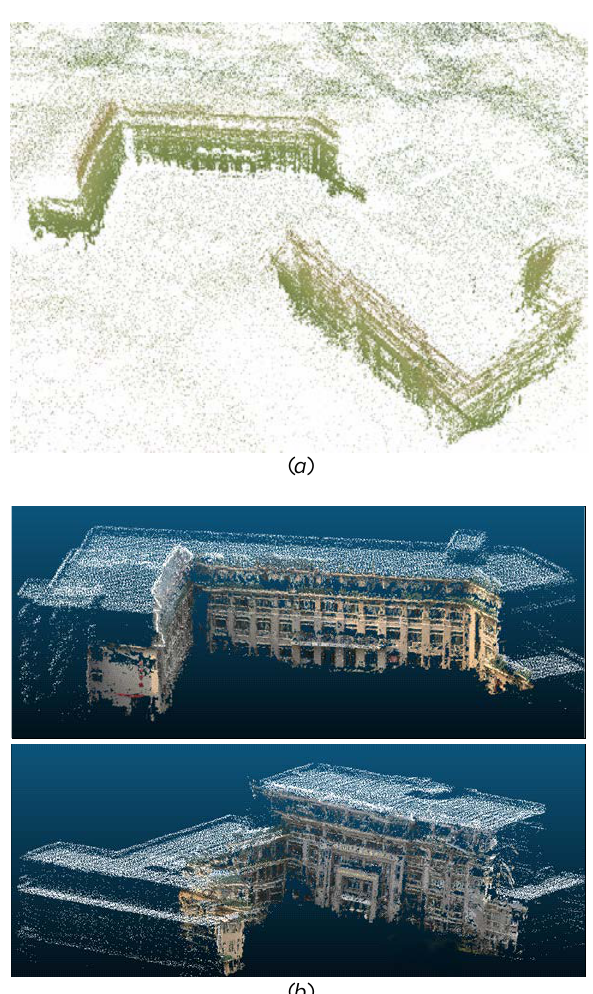
Figure 10. Integrated point clouds. (a) the two buildings within airborne LiDAR point cloud. (b) the student dorm (top) and instruction building